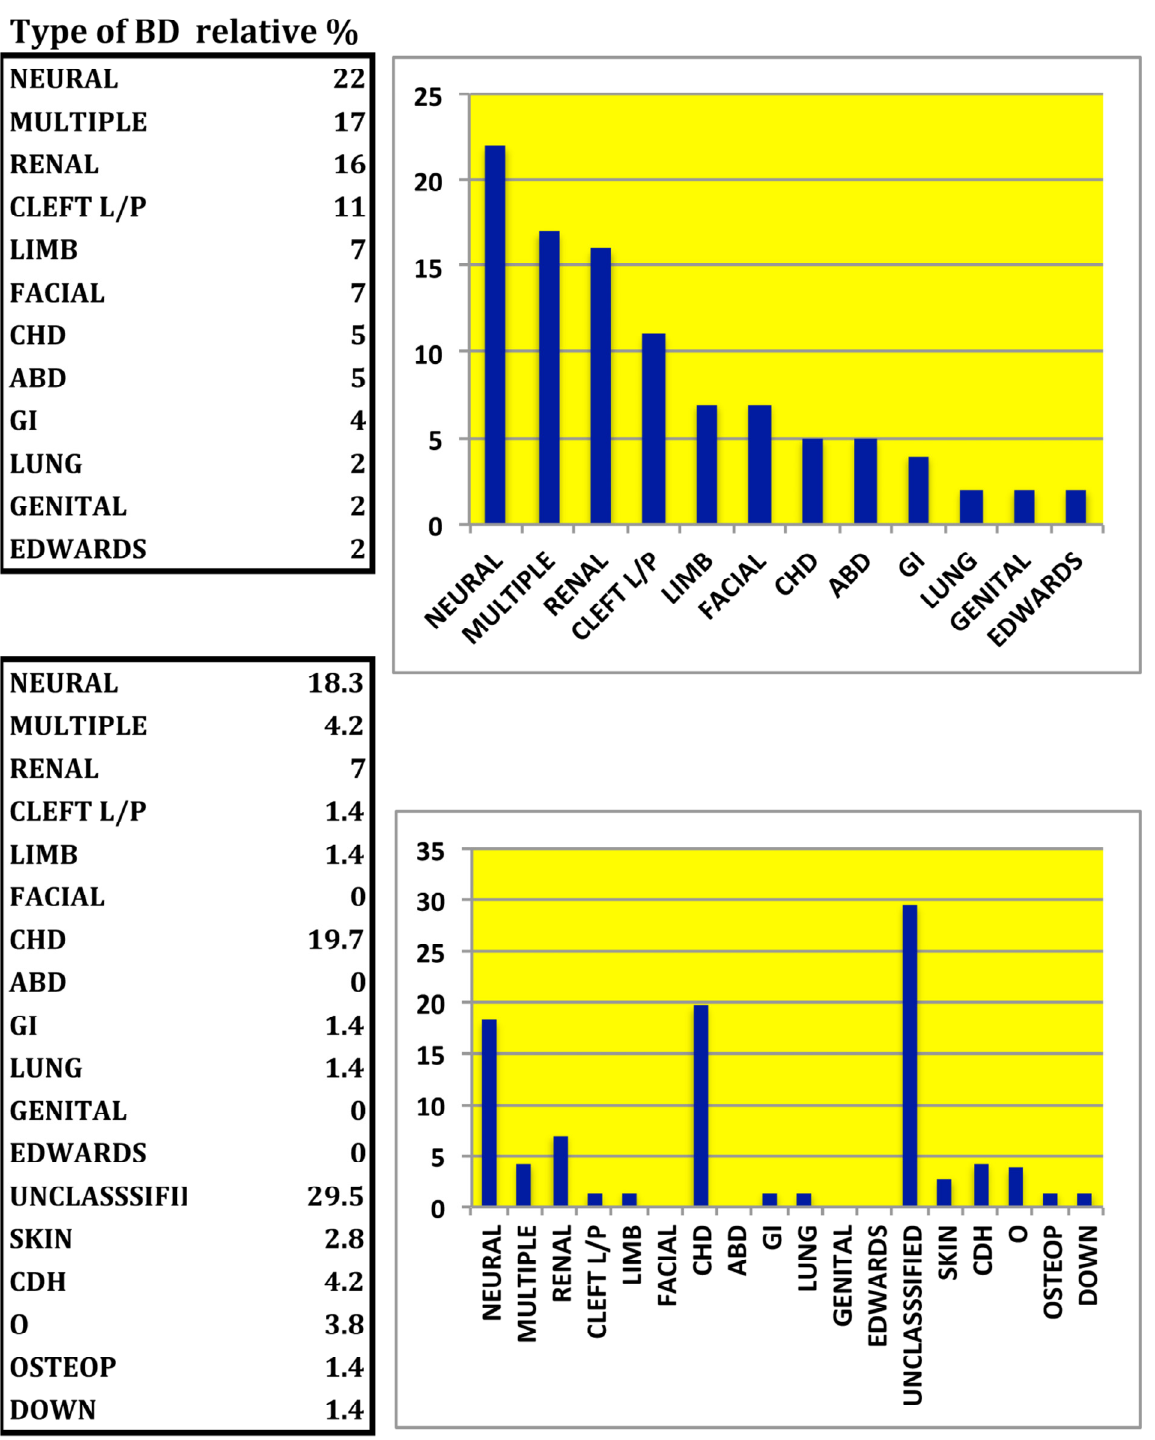
Figure 1. Type of Birth defects. The relative presence among BD (top panel) and PBD (bottom panel) is expressed in percentage of the type of defect: GI gastrointestinal, CHD congenital heart disease, ABD Abodminal wall defect, CDH Congenital displasia of hip, O Others undescribed, OSTEP